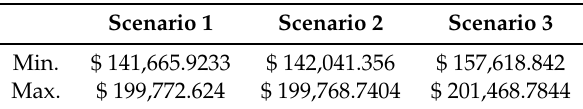
Table 6. Results for the total daily